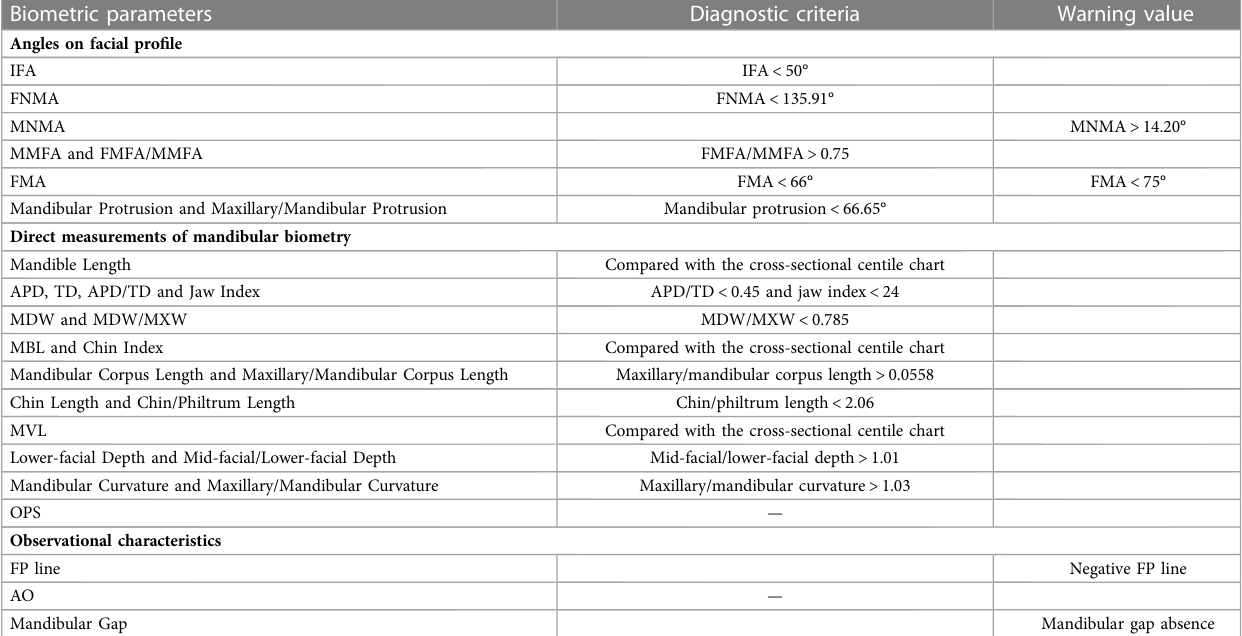
TABLE 3 The parameters to assess micrognathia using angles on facial pro fi le, direct measurements of mandibular biometry and observational characteristics. Biometric